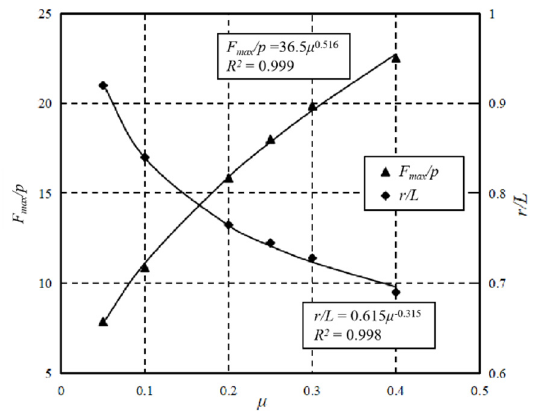
Figure 8. Normalized maximum axial load and normalized position of neutral point versus fric- tion coefficient.